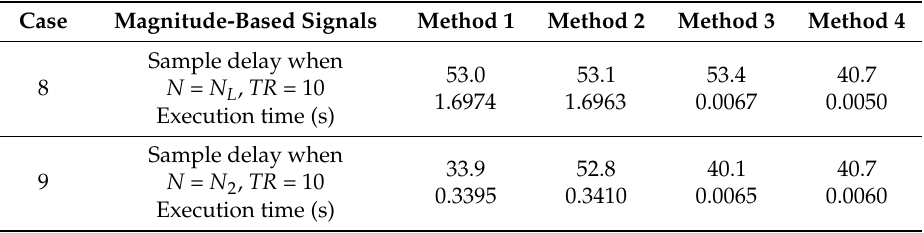
Table 4. Estimated sample delay and program execution time for a vehicle that traveled at 33.3 km/h; the values were estimated for r = 10.